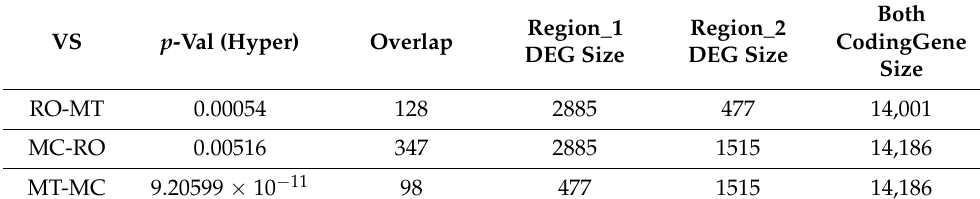
Both Region_1 Region_2 CodingGene DEG Size DEG Size Size